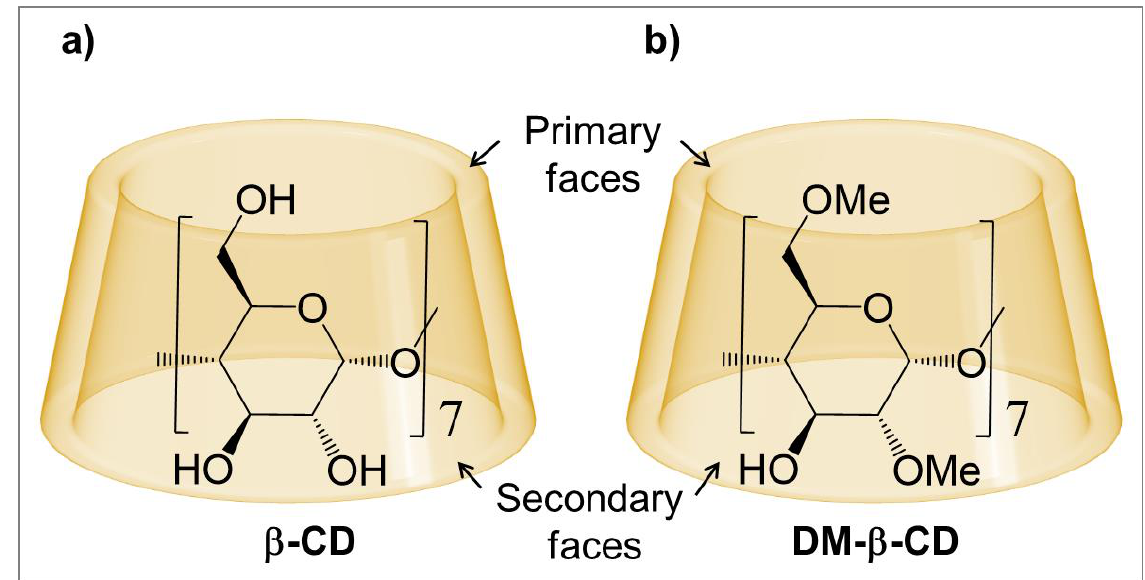
Figure 1. Schematic of the macrocycles: ( a ) β -Cyclodextrin ( β -CD ) and ( b ) Heptakis(2,6-di-O-methyl)- β -cyclodextrin ( DM- β -CD ).